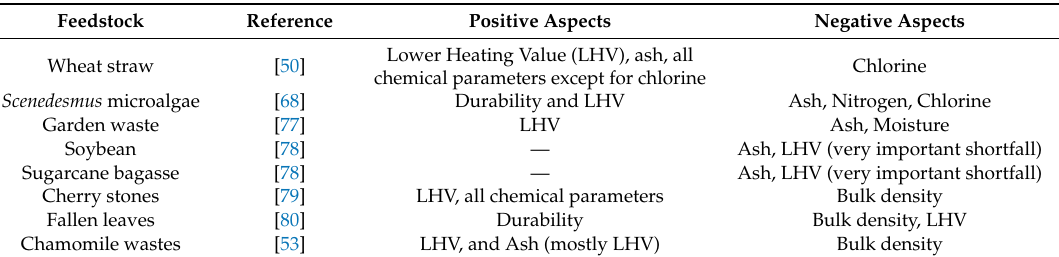
Table 2. Main postive and negative aspects found in the literature for relatively new feedstocks for pellet